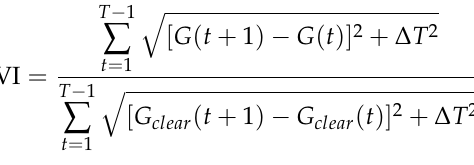
Figure 4. Kernel density estimates of clear-sky index increments, using about 4.5 single-sensor 1s data collected during the HOPE campaign [138,139]. The estimates were derived for increment time steps τ = 5s, τ = 10s, and τ = 60s using Gaussian kernels with a smoothing bandwidth of